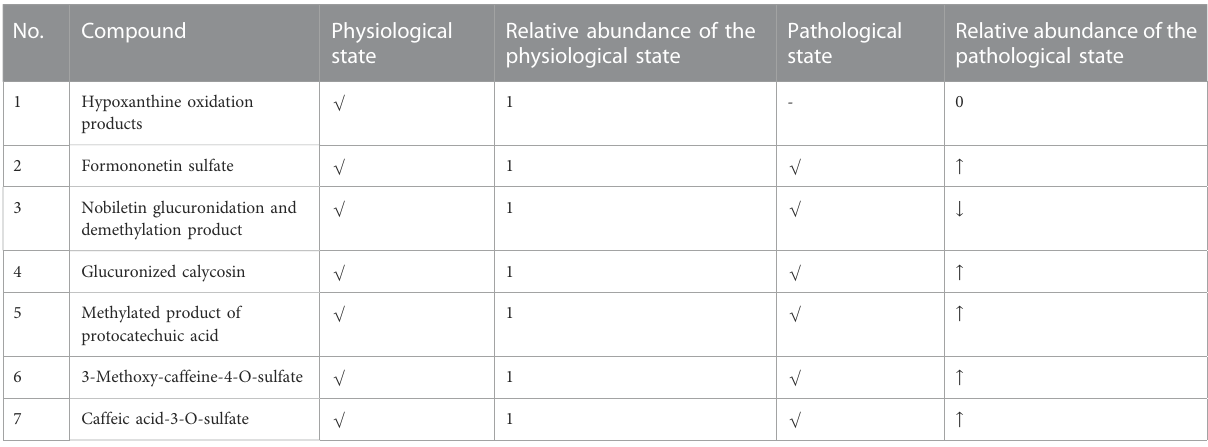
TABLE 3 Difference of metabolites in the